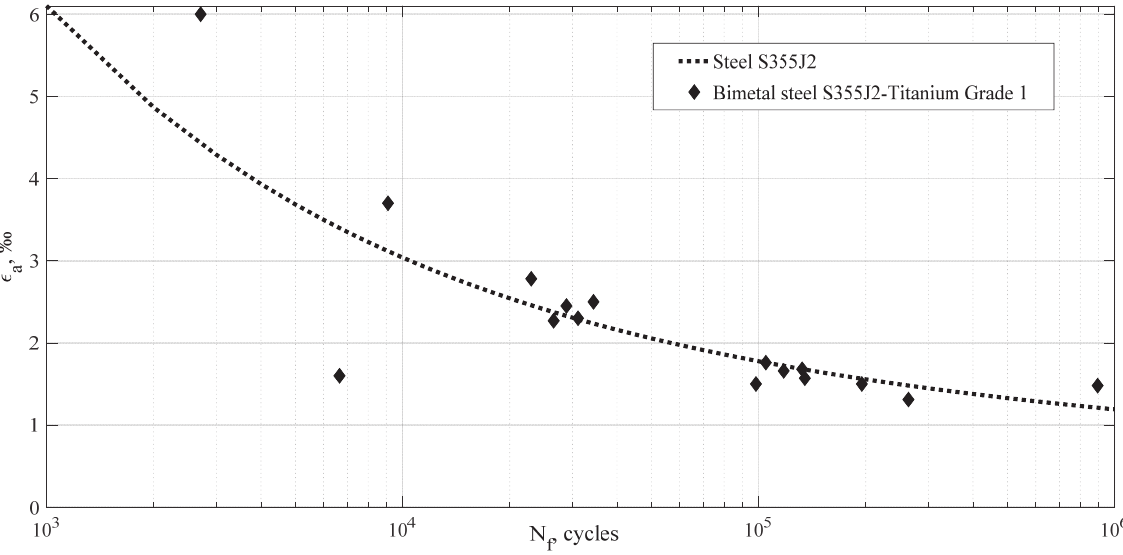
Figure 9: Experimental points (steel – titanium specimens) and fatigue characteristic of S355J2